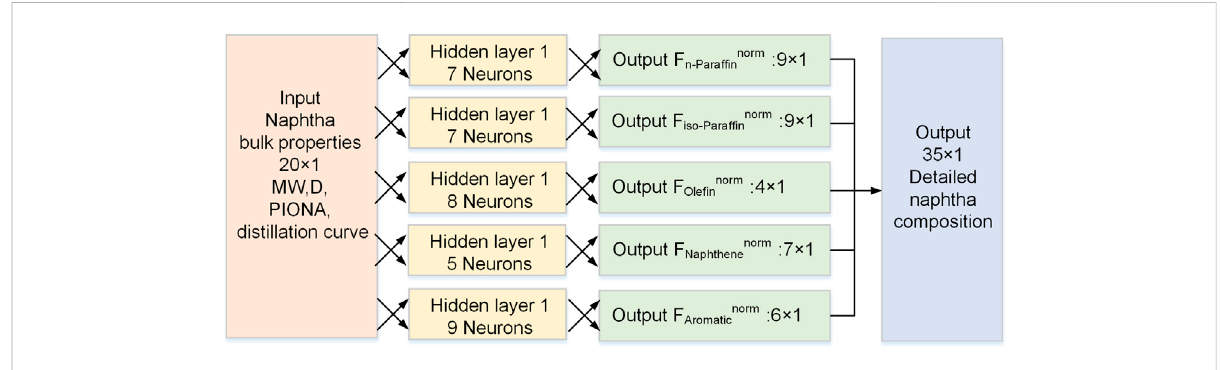
FIGURE 4 The network structure of the indirect ANN model.